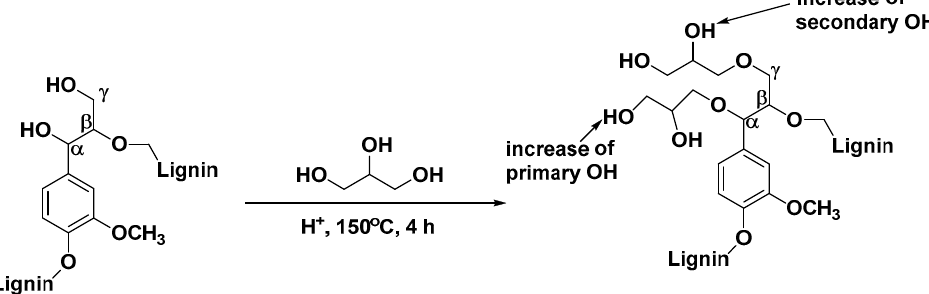
Figure 8. Reaction between lignin and glycerol—acid-catalyzed (p-toluene sulfonic acid) wood liquefaction (Adapted from [74] ).